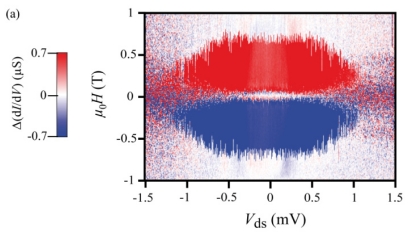
Bias and temperature dependences of the conductance hysteresis loops: (a) Color scale map of the dI/dV hysteresis as a function of in-plane magnetic field and source drain voltage Vds. The magnetic hysteresis are suppressed above Vds = ± 1 mV; (b) 15 records of conductance hysteresis loops for several temperatures ranging from 0.04 to 1 K at a constant sweep rate of 50 mT/s. The curves for T > 40 mK are offset by a multiple of 200 nS for clarity.